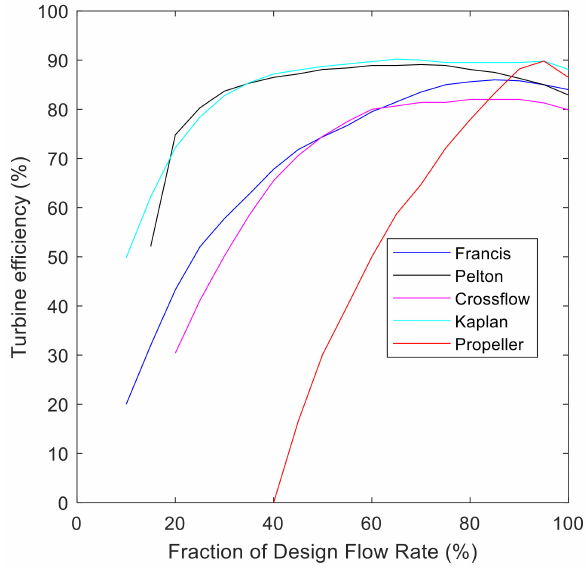
Figure 6. Summary plot of the turbine efficiencies relative to the designed flow